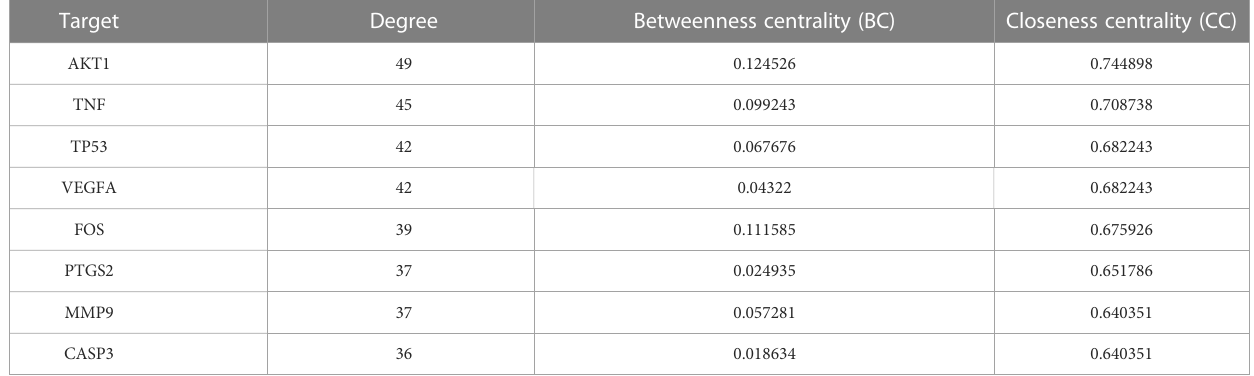
TABLE 2 Core target information table.